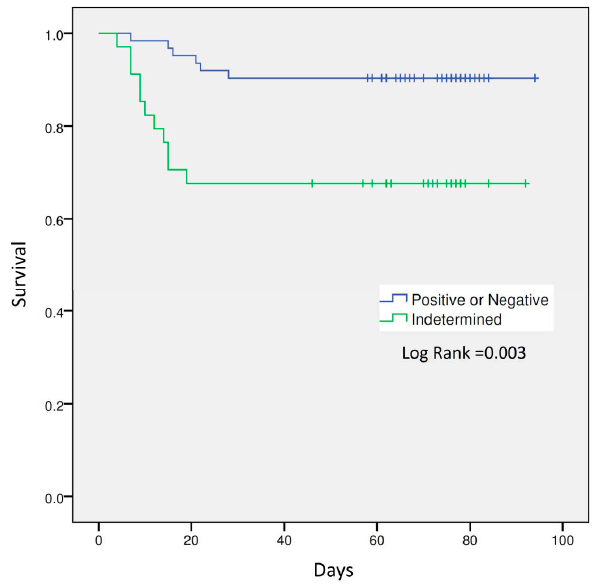
Figure 1. Kaplan–Meier survival curves for patients with interpretable (positive or negative) and indeterminate QFT-Plus assay results.